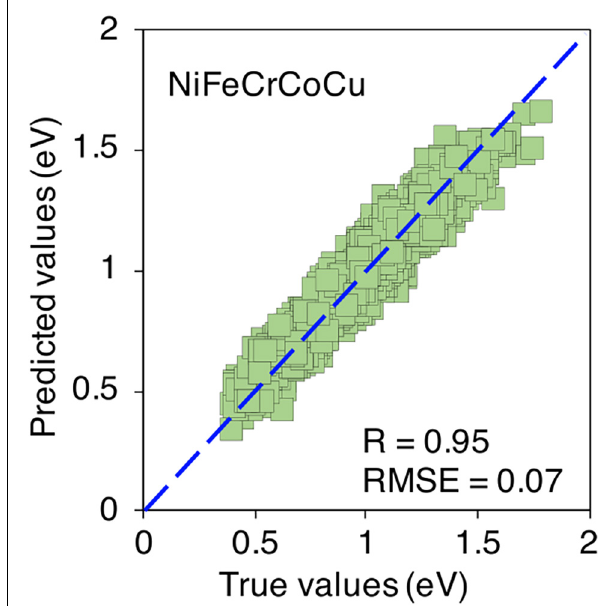
FIGURE 9 | True vs ML predicted migration energies of equi-atomic NiFeCrCoCu